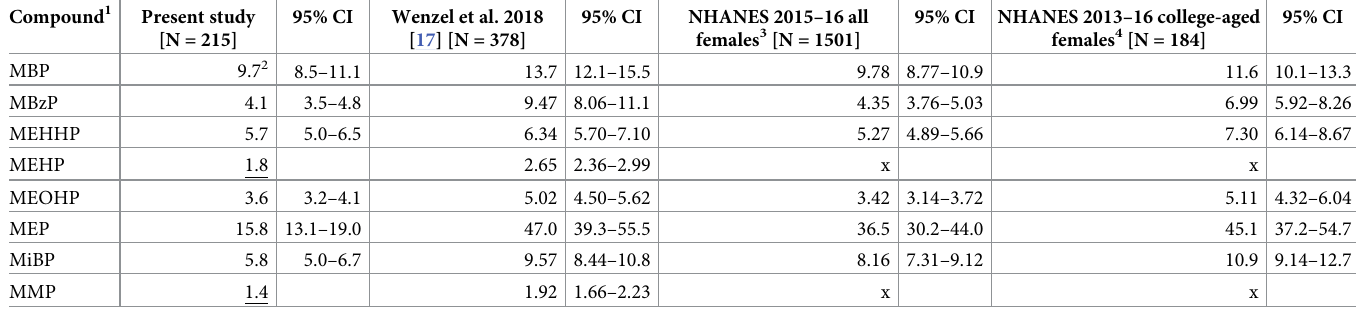
Table 2. Geometric mean unadjusted concentrations (ng/mL) with 95% confidence intervals (CI) of urinary phthalate metabolites in comparison to reference populations. Compound 1 Present study [N =